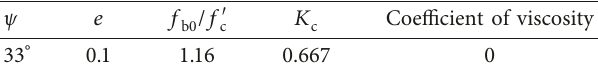
Table 1: CDP model